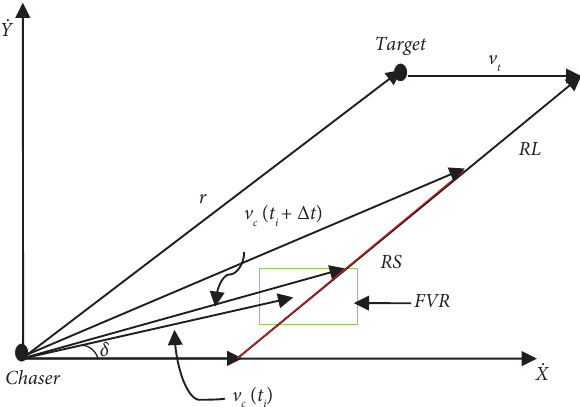
Figure 3: Construction of rendezvous set with feasible velocity